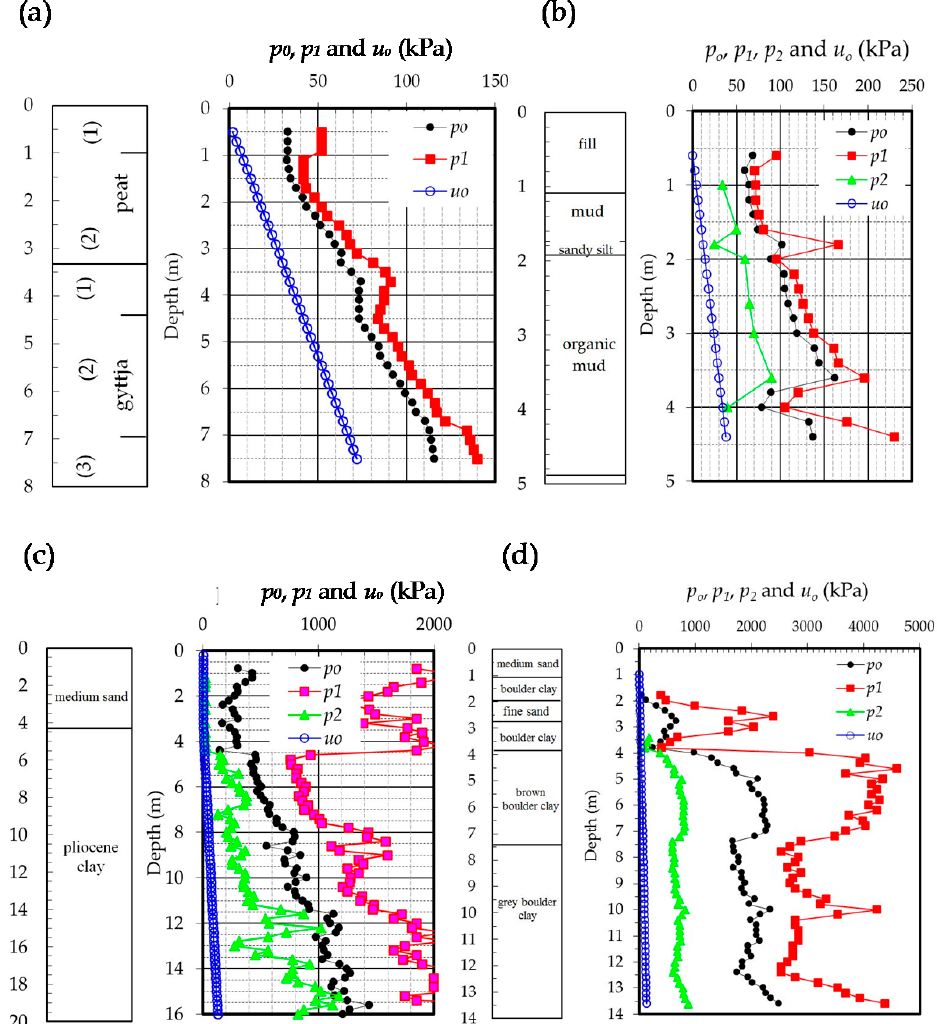
Figure 7. Profiles of p 0 , p 1 and p 2 from dilatometer (DMT) and hydrostatic pressure u o tests: ( a ) for the Antoniny site; ( b )—for the Nielisz subsoil; ( c )—for the Stegny subsoil; ( d )—for the SGGW Campus subsoil